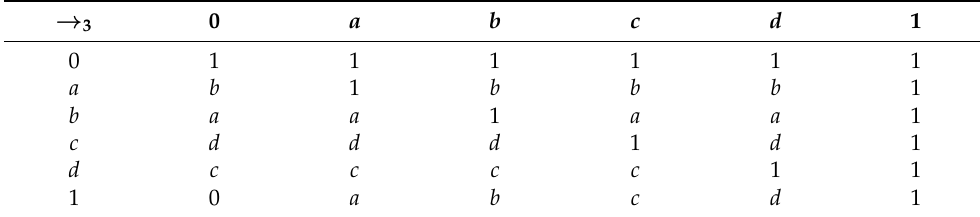
Table 12. The operation → 3 .